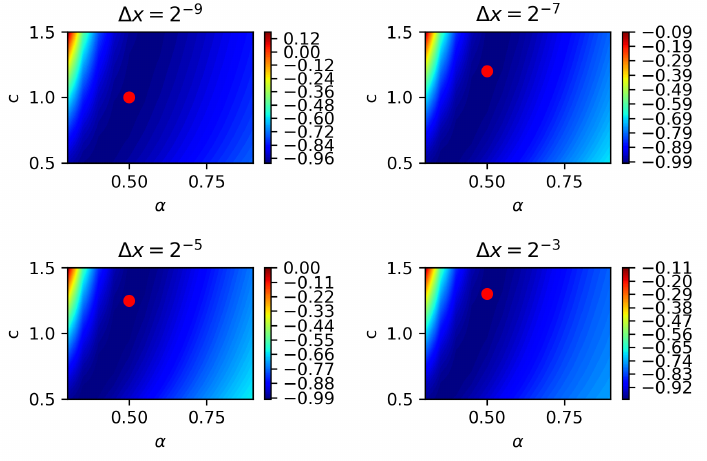
Figure 7. Two-parameter estimation: Contour plots of normalized negative log-likelihood for pairs of ( α , c ) ∈ [ 0.3,0.9 ] × [ 0.5,1.5 ] . The effect of spatio step on the estimated parameters is demonstrated.